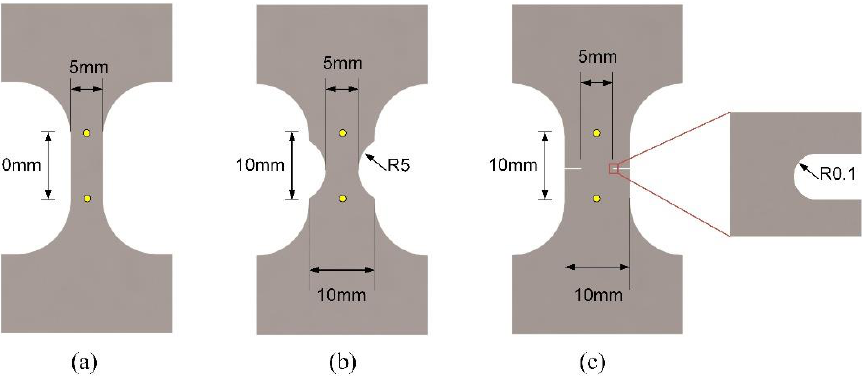
Figure 2. Sample geometry used for: ( a ) Uniaxial; ( b ) notched tension (R = 5 mm); ( c ) notched (R = 0.1 mm). The yellow points indicate the location for measuring relative displacement by digital image correlation (DIC).